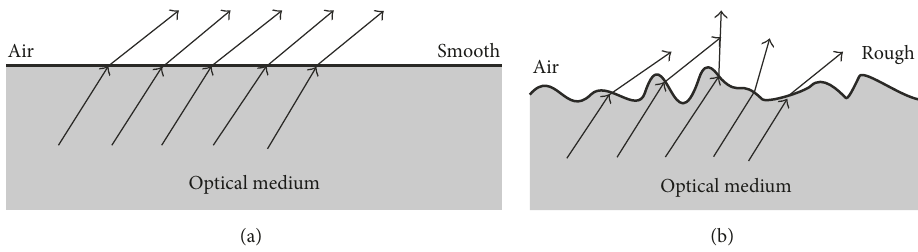
Figure 3: (a) Schema of lights propagation at smooth and (b) rough optical surface.